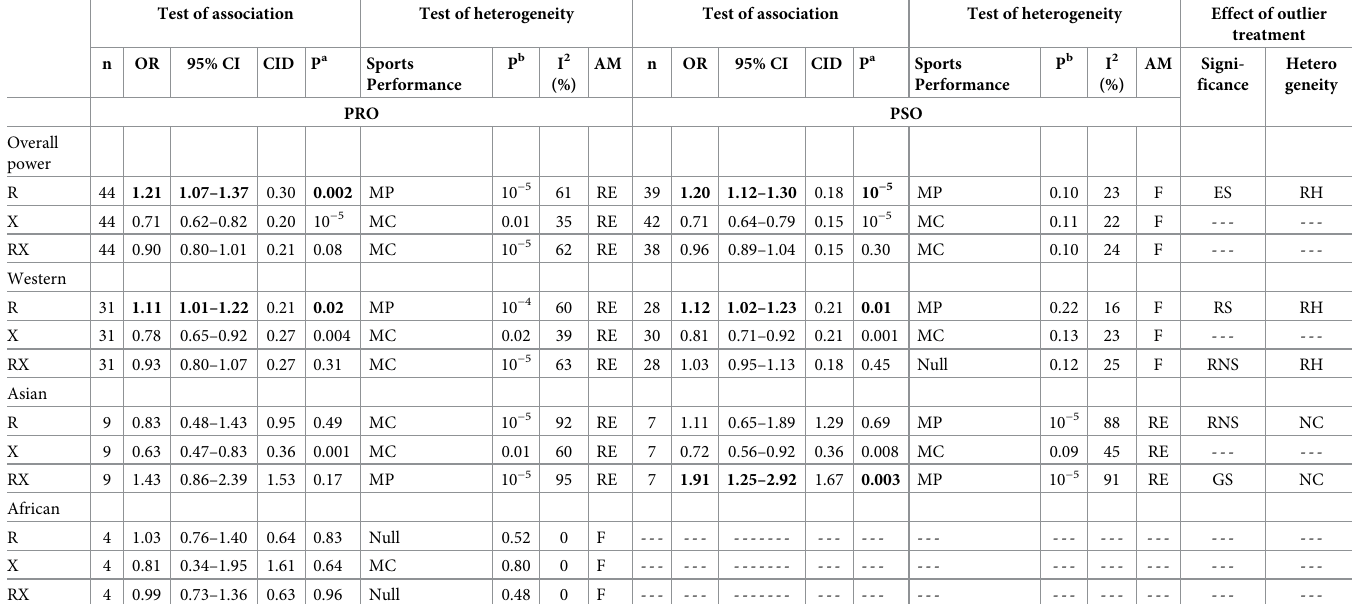
Table 1. Overall analysis of R allele in ACTN3 R577X polymorphism with power sports. Test of association Test of heterogeneity Test of association Test of heterogeneity Effect of outlier